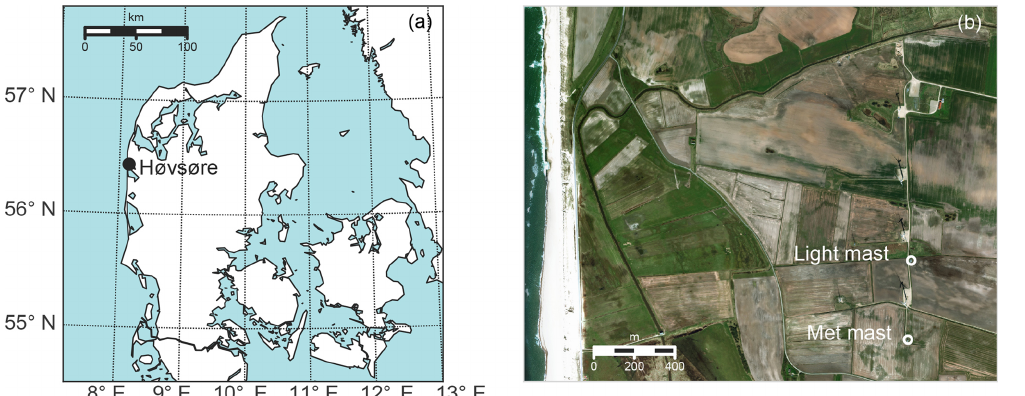
Figure 1. (a) Map of Denmark showing the location of Høvsøre. (b) Overview of the Høvsøre test center showing the position of the met mast and the light mast with white circles.